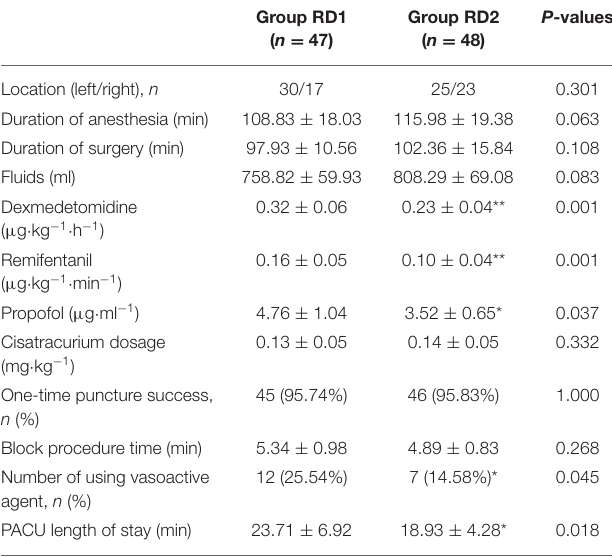
TABLE 2 | Intraoperative data between the two groups.